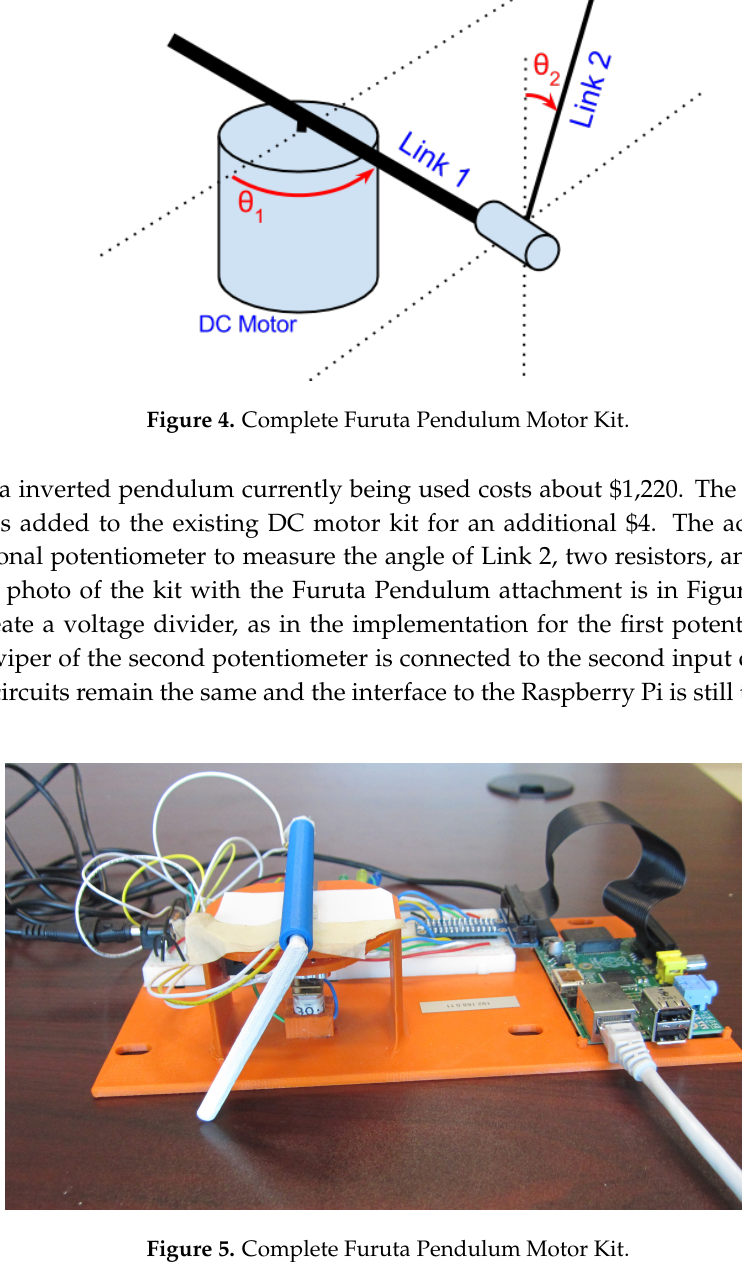
Figure 5. Complete Furuta Pendulum Motor